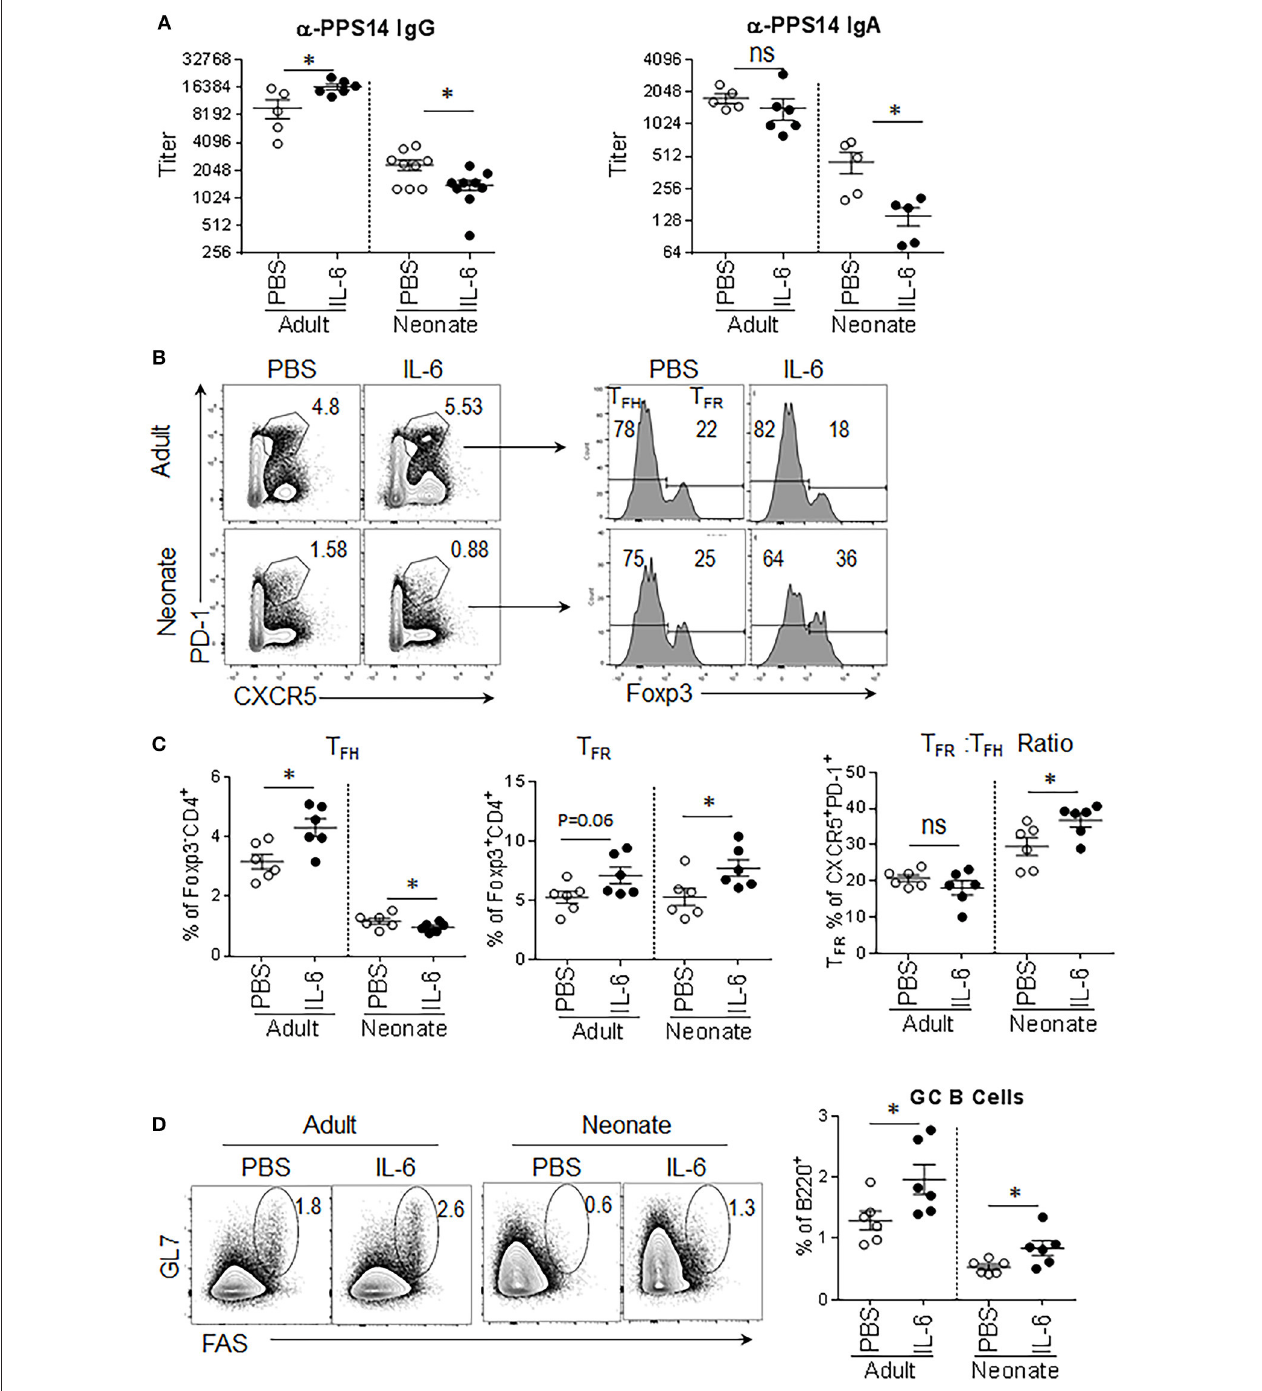
FIGURE 2 | Antibody responses to PPS14-TT vaccine are diminished when IL-6 is co-injected. Adult (6–10 week-old) and neonatal (5 day-old) mice were immunized i.p. with PPS14-TT alone or with IL-6 (500 ng/adult, 100 ng/neonate) and splenocytes were analyzed in flow cytometry at 7 dpi. (A) Serum anti-PPS14 IgG and IgA titers were determined in ELISA 6 weeks after immunization ( n = 6–9). (B) Representative dot plots depict the percentage of T FH (CD4 + CXCR5 + PD-1 + Foxp3 − ) and T FR (CD4 + CXCR5 + PD-1 + Foxp3 + ) cells. (C) Mean percentages of T FH cells among Foxp3 − CD4 + cells and T FR cells among Foxp3 + CD4 + cells are shown. The ratio of T FR to T FH cells (T FR : T FH ) are plotted ( n = 6). (D) Representative dot plots depict mean percentage of GC B (GL-7 + FAS + ) cells. Plots were pre-gated on B220 + cells ( n = 6). One out of two experiments with similar results is shown. Error bar, s.e.m.. * p < 0.05.